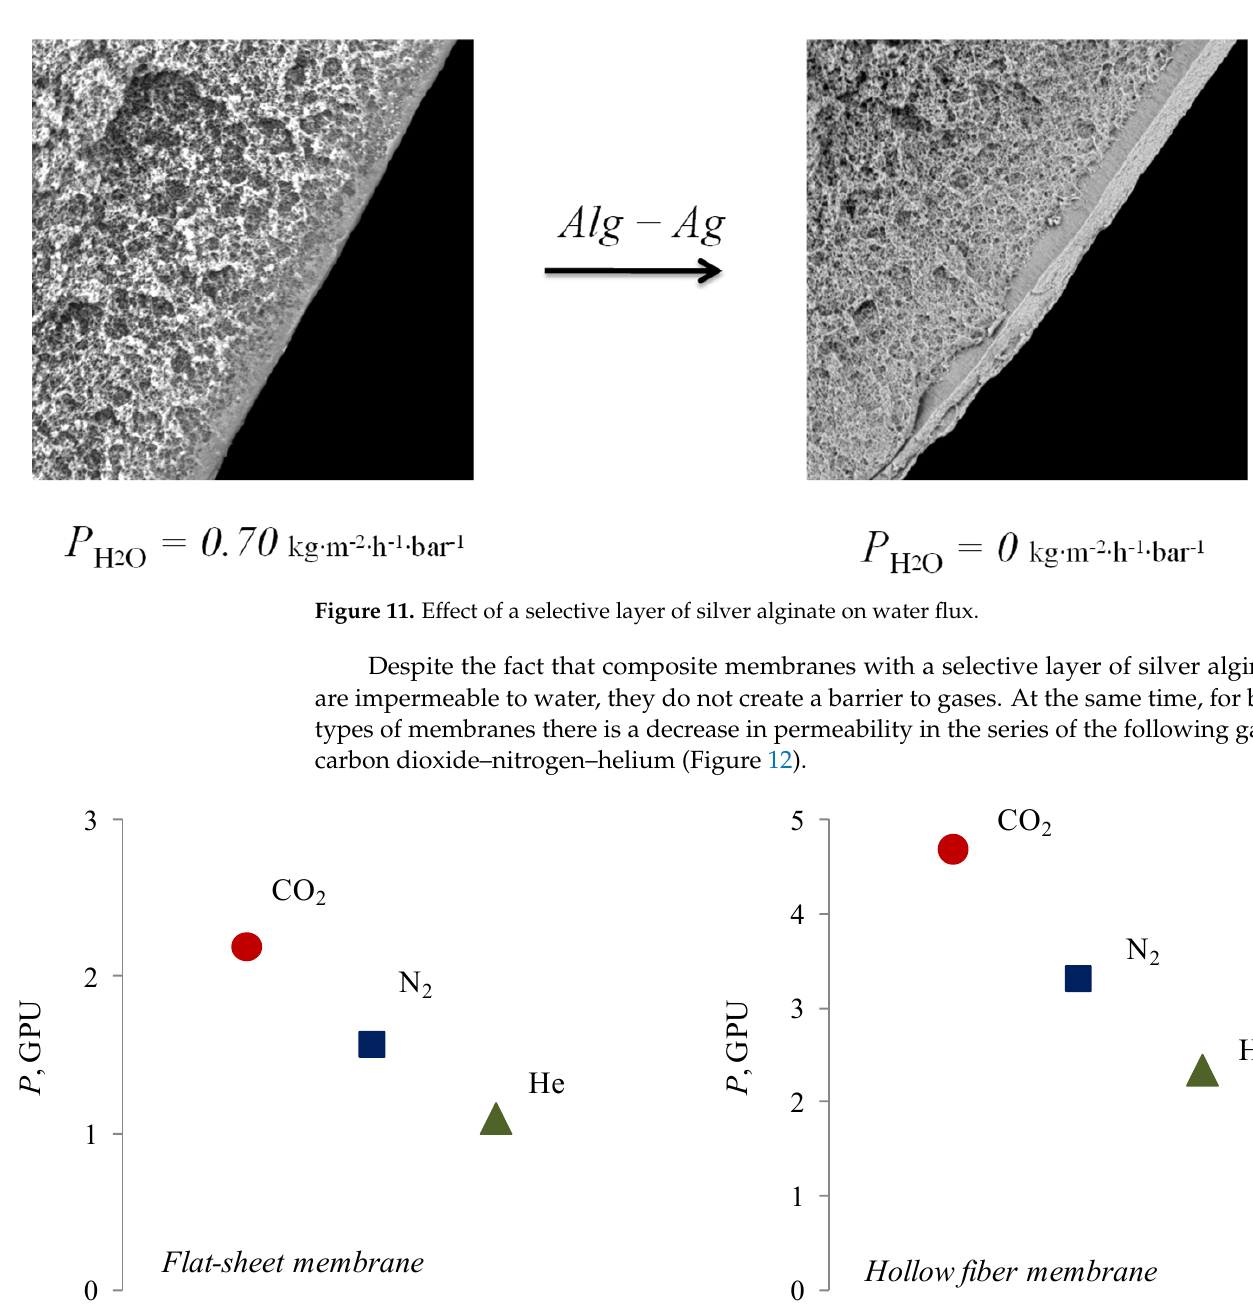
Figure 12. Permeability of flat ( A ) and hollow-fiber ( B ) composite membranes with a silver alginate selective layer for pure gases. Thickness of Alg-Agis 20 µm.